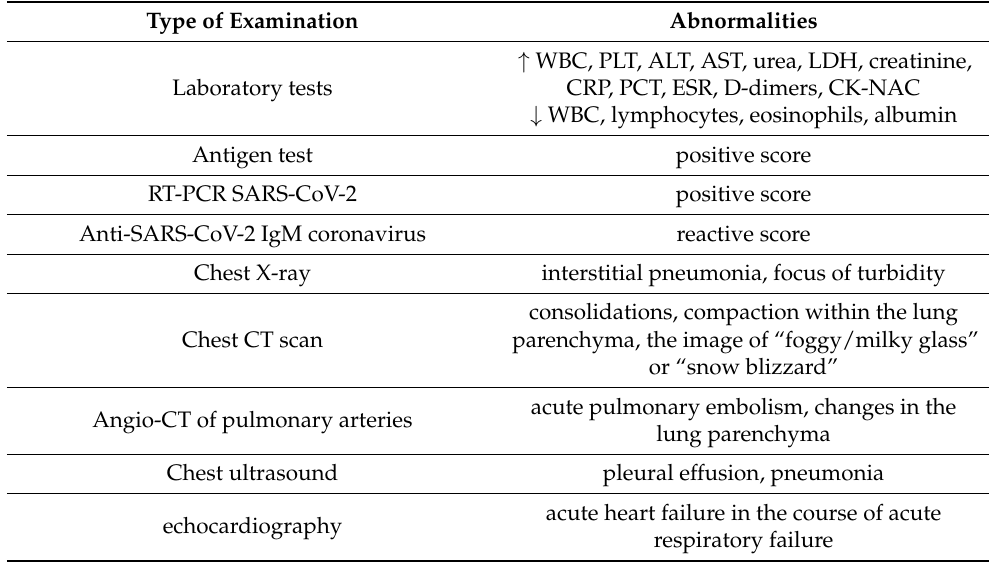
Table 2. Selected abnormalities in additional tests in the course of SARS-CoV-2